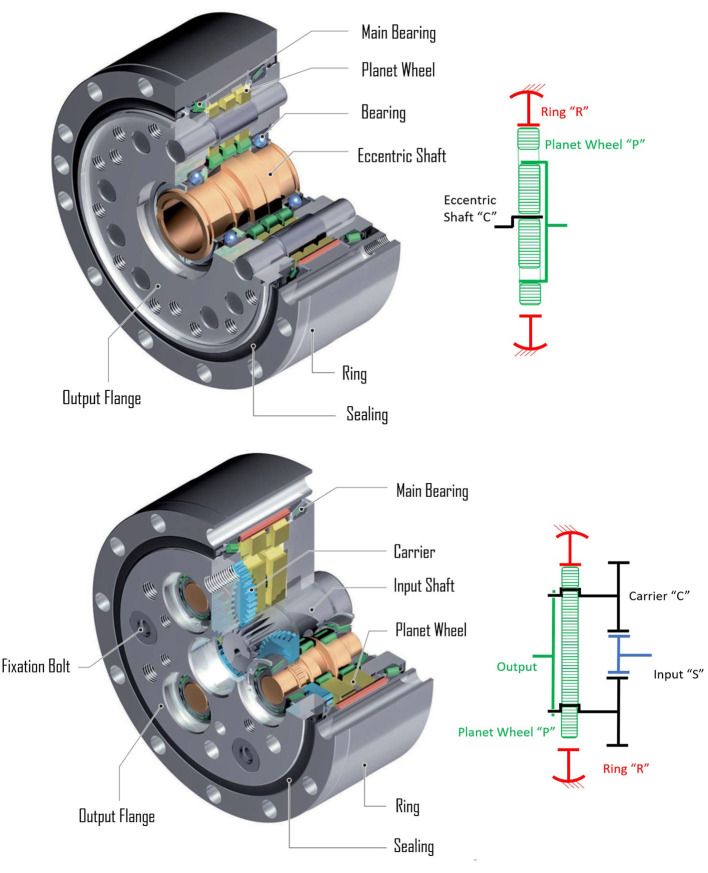
Internal configuration of a SUMITOMO Fine Cyclo F2C-A15 and a Fine Cyclo F2C-T155 cycloid drives identifying its main elements, adapted from SUMITOMO (2017) with permission of © 2017 Sumitomo Cyclo Drive Germany GmbH. It includes also a schema of its underlying topologies.